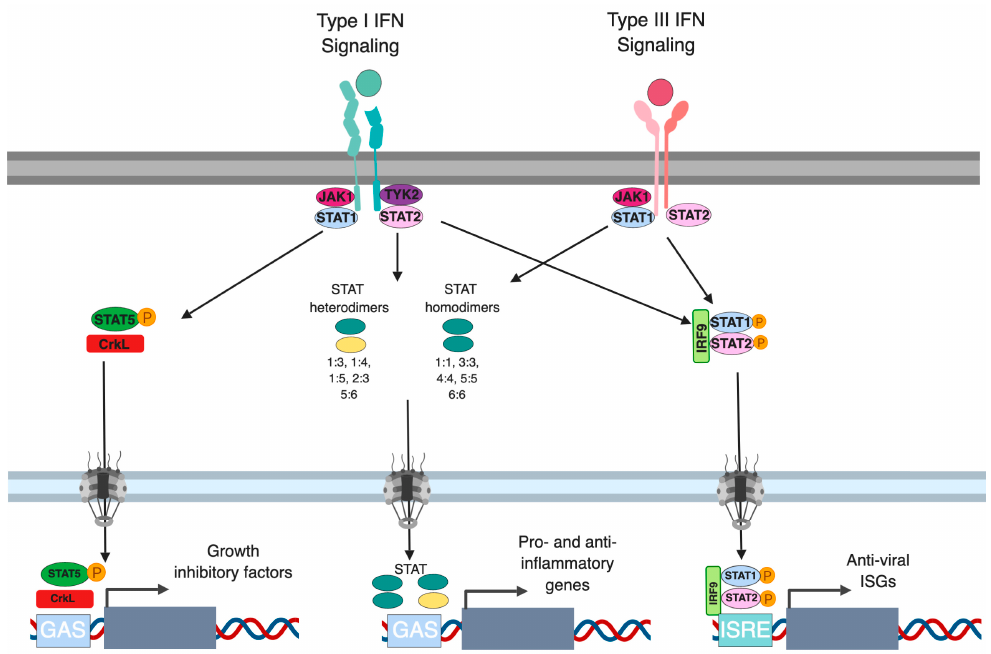
Figure 3. Signal transduction downstream type I and III interferon. Upon binding of type I IFN to the IFNAR1/IFNAR2 and of type III IFN to the IFNLR1/IL-10R2 receptor transactivation of JAK1 and TYK2 leads to the phosphorylation of STATs. Upon phosphorylation STAT molecules form three main complexes 1) STAT5/CrkL, 2) STAT homo- or heterodimers and 3) the ISGF3 complex (IRF9/p-STAT1/p-STAT2). All of these complexes act as transcription factors driving the production of interferon stimulated genes through the binding of specific motifs in their promoter sequences: GAS and ISRE elements.